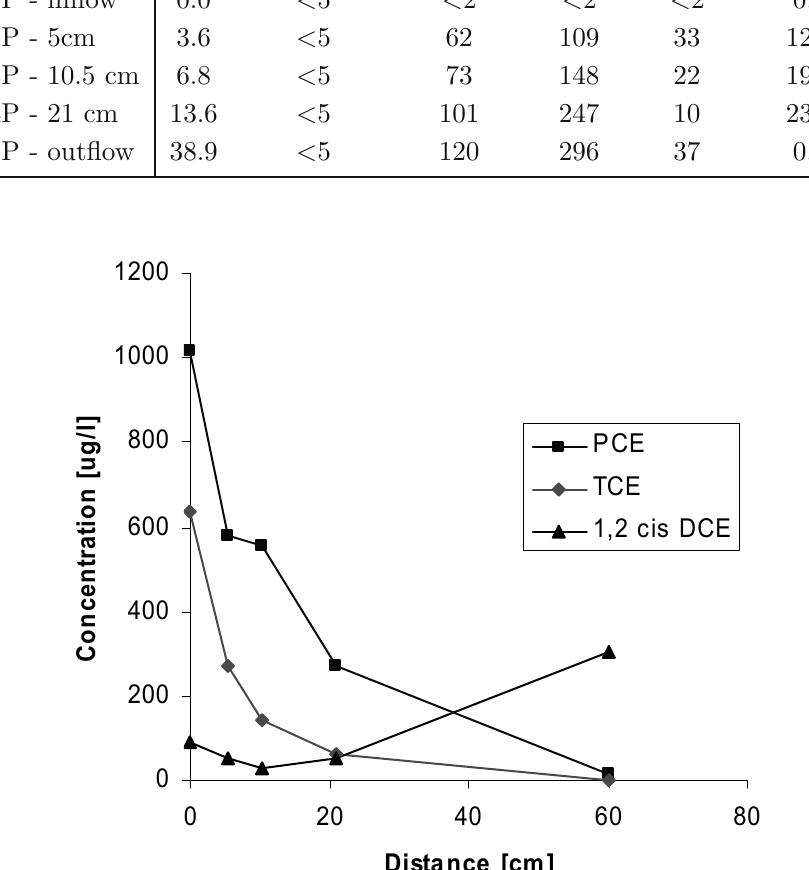
Fig. 3 Concentration of chlorinated ethenes for a flow velocity of 37 cm/day (residence time in the reactive zone 1.62 days) after 1.5 months of